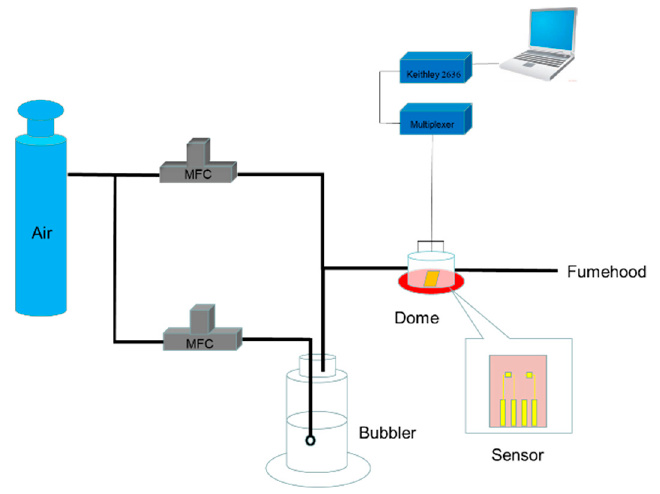
Figure 2. Schematic diagram of gas sensing device.